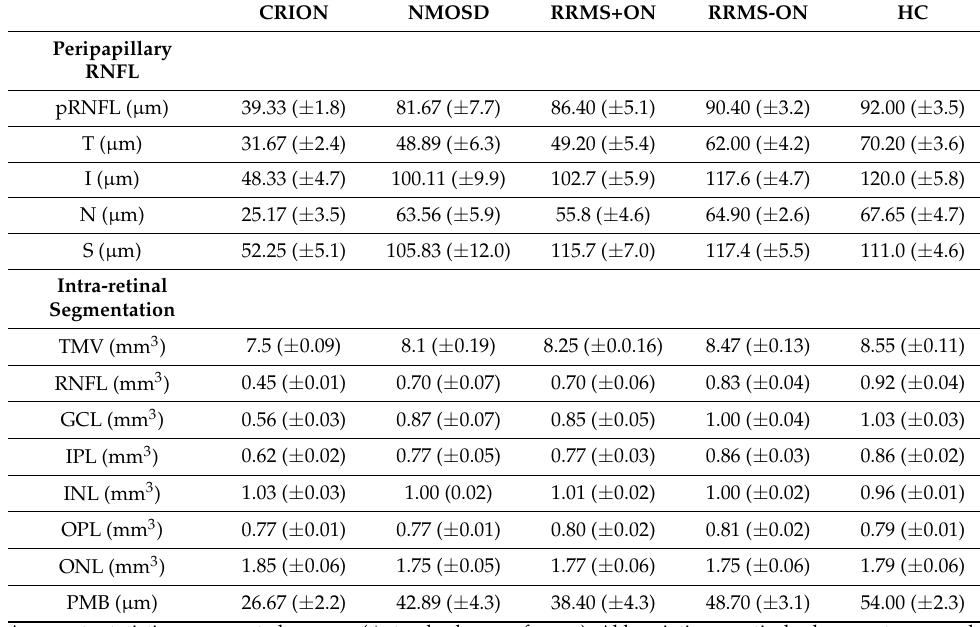
Table 2. OCT Data of all participants (CRION, NMOSD, RRMS+ON, RRMS-ON, and HC).